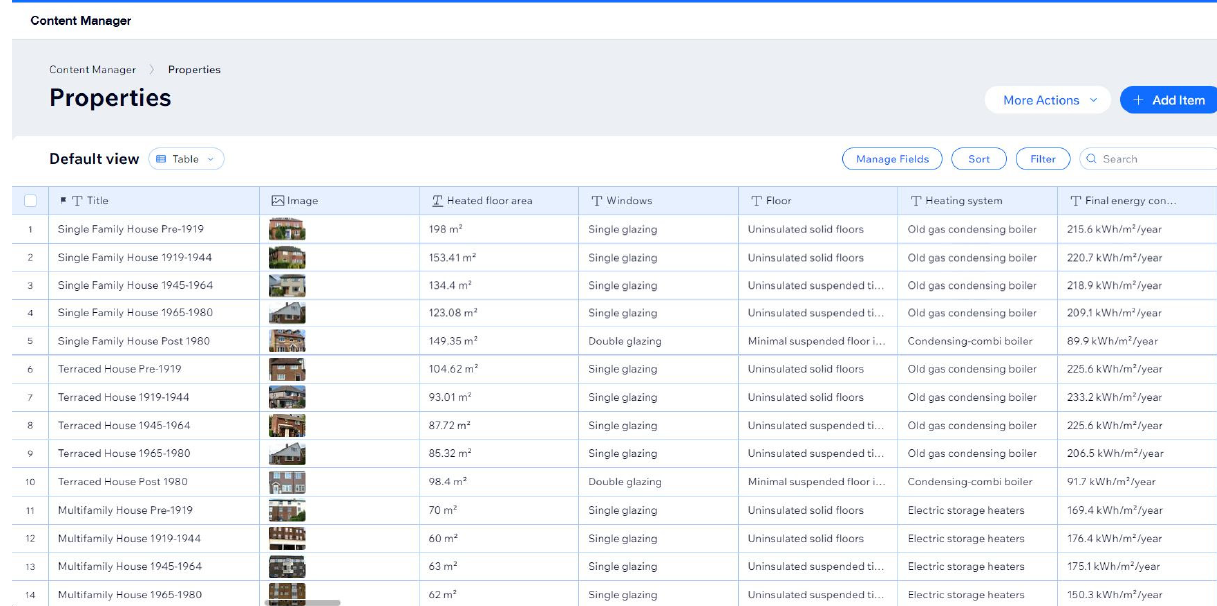
Figure 3. Data entered into Wix Content Manager.